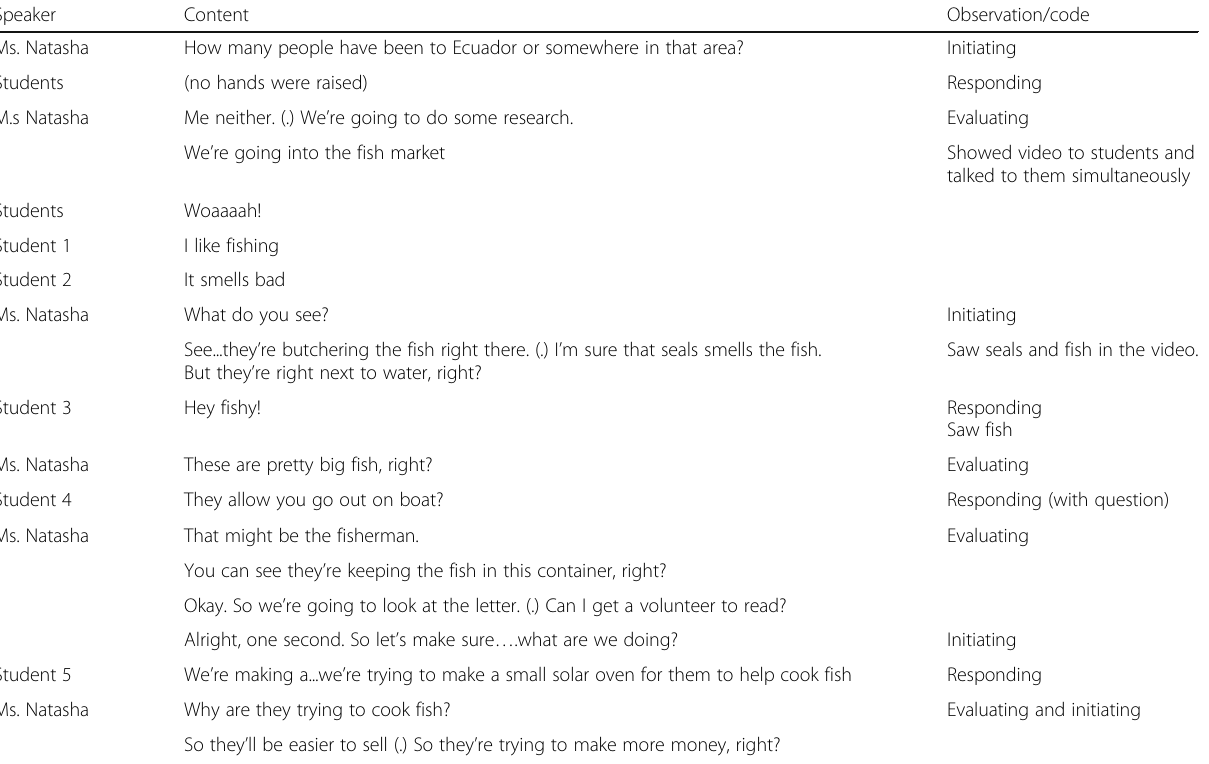
Table 6 Conversation between Ms. Natasha and her students during the first day of the unit in lesson 1